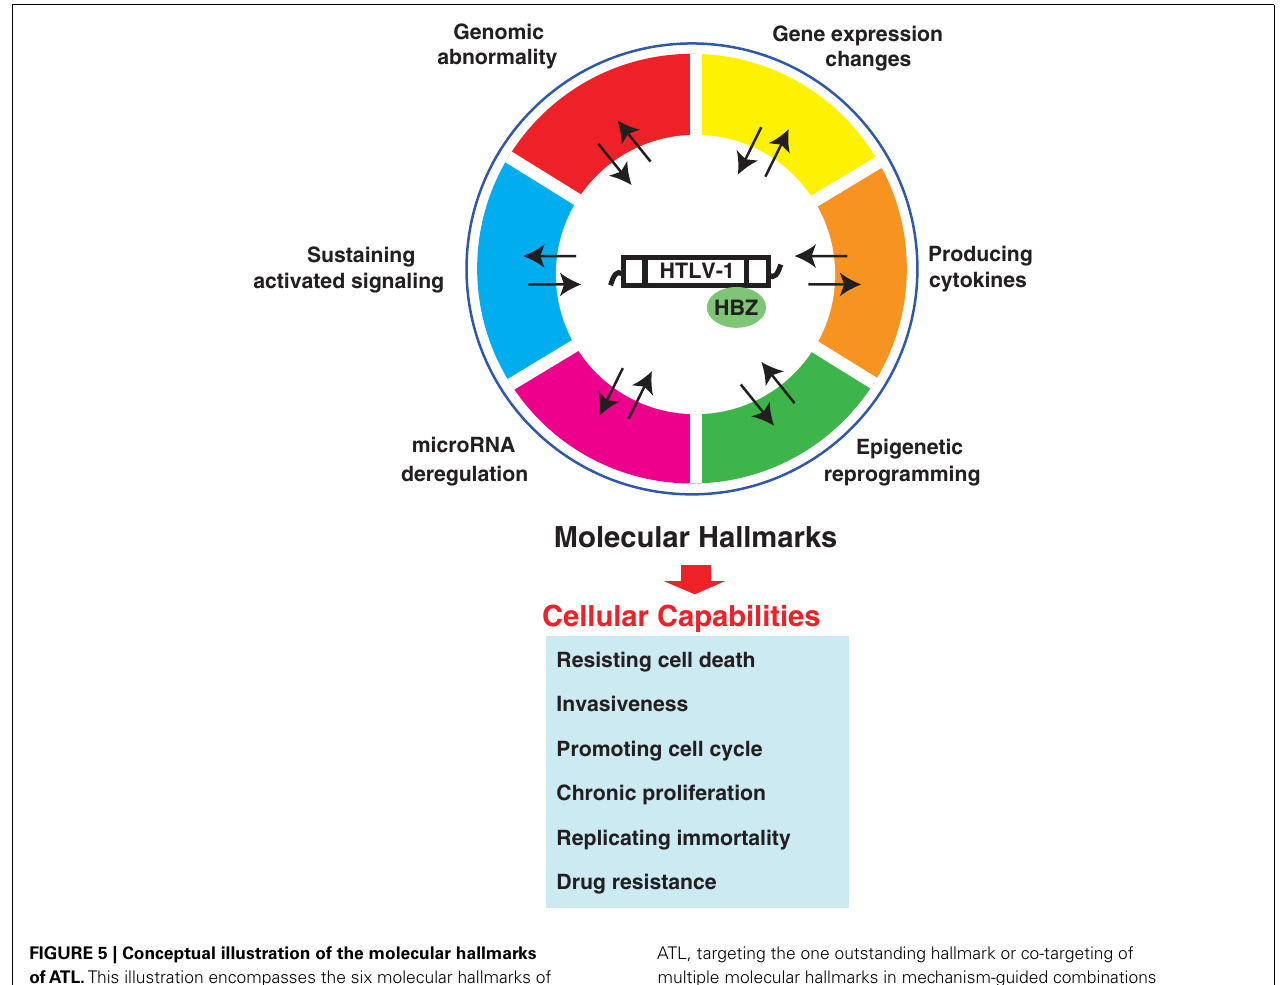
FIGURE 5 | Conceptual illustration of the molecular hallmarks ofATL. This illustration encompasses the six molecular hallmarks of ATL.These organized principles provide characteristics of ATL itself. Because they may be directly associated with the clinical traits of